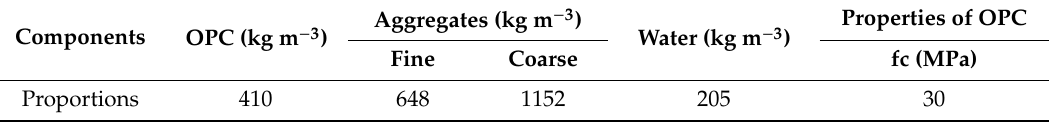
Table 2. Mix proportion and strength of